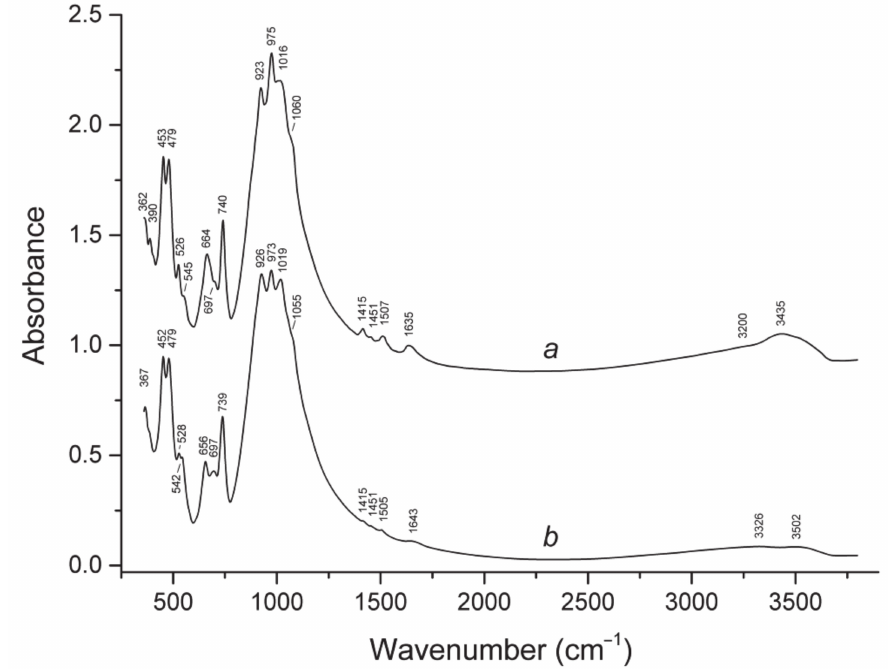
Figure 3. Powder infrared absorption spectra of ( a ) odikhinchaite and ( b ) taseqite, both from the Odikhincha alkaline